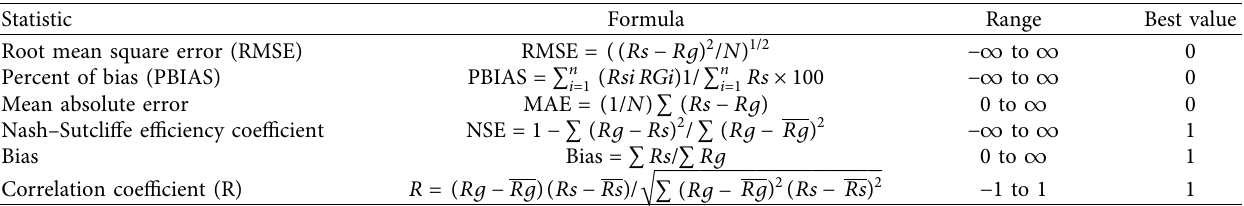
Table 3: Statistical measures of performance used for analysis based on continuous metrics.